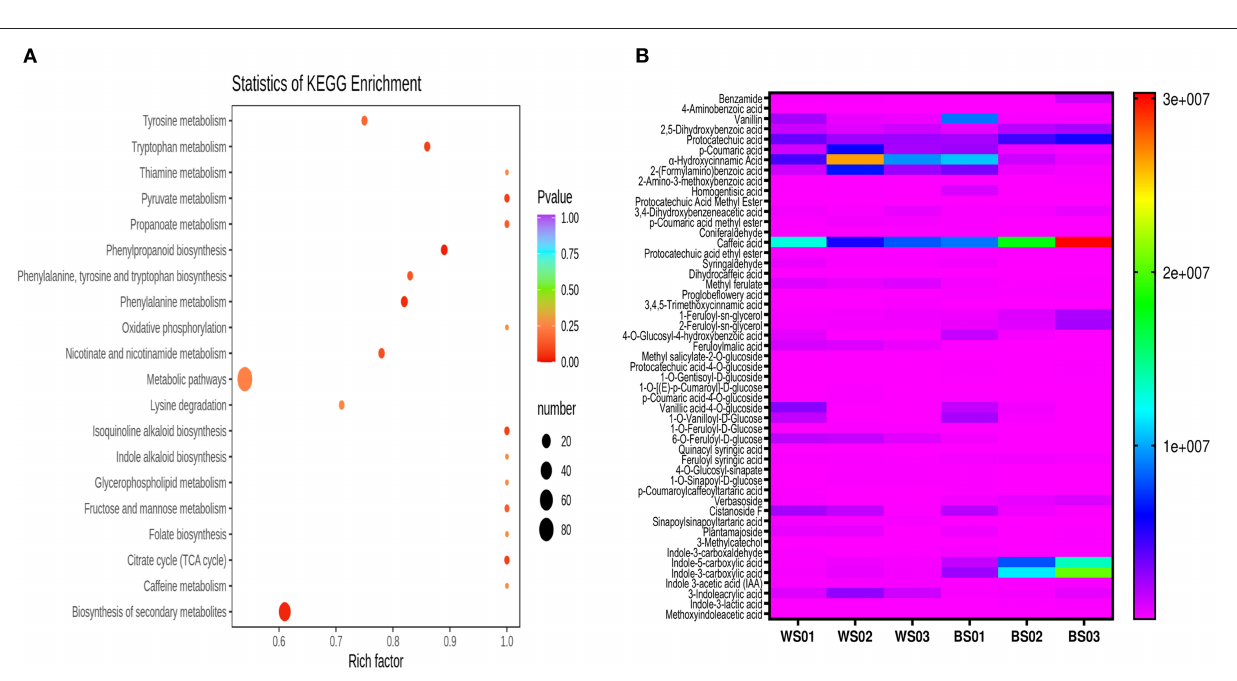
FIGURE 7 | Differential accumulated metabolites (DAMs) between white and black sesame seed in NaOH extracts. (A) KEGG annotations and enrichment results of the DAMs between white and black sesame seeds. (B) Comparison of the relative content of differentially accumulated phenolic acids between white (WS) and black sesame (BS) seeds. The definition of labels is presented in Supplementary Table S1